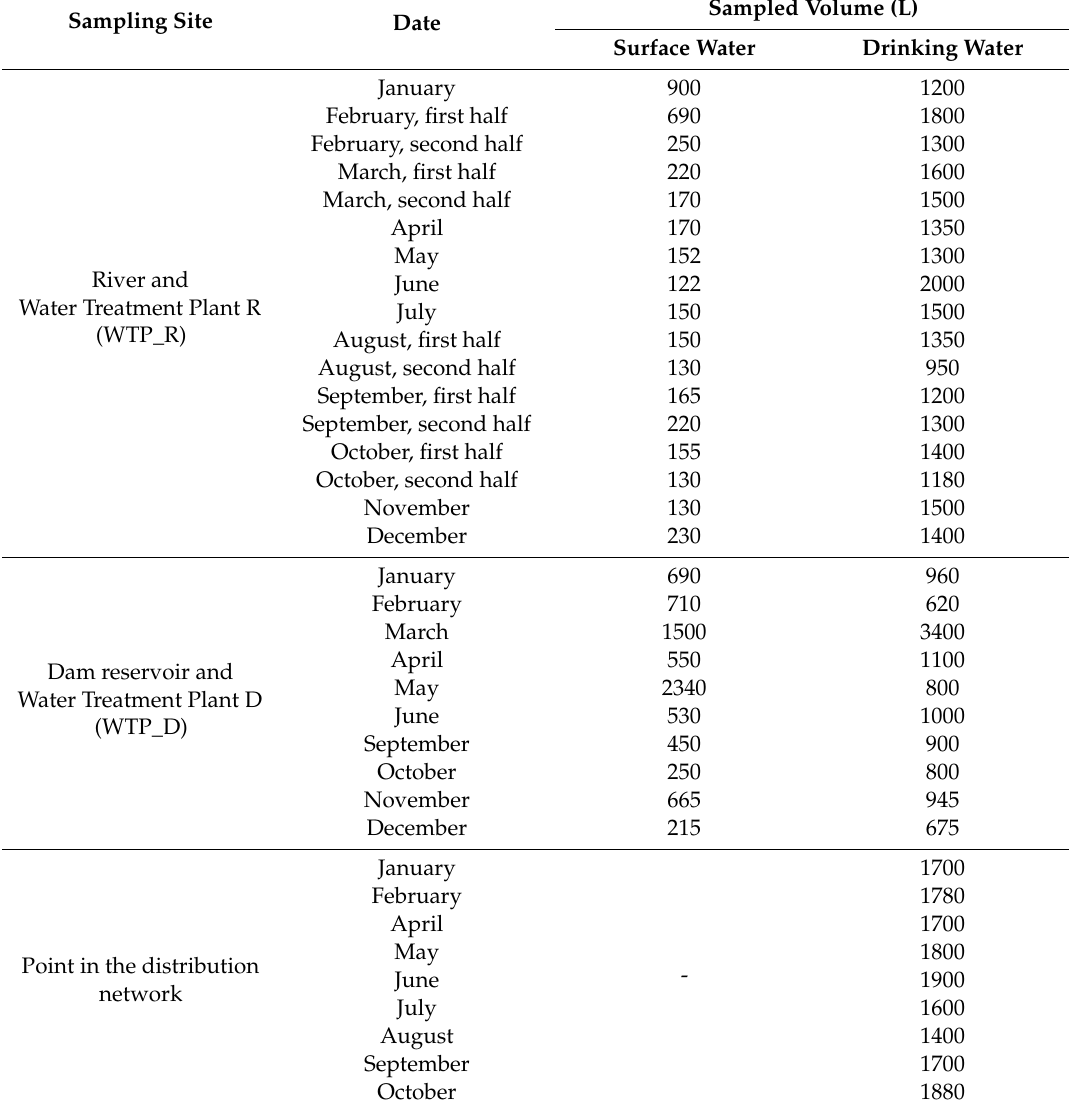
Table 1. Water surveyed from five sampling sites in